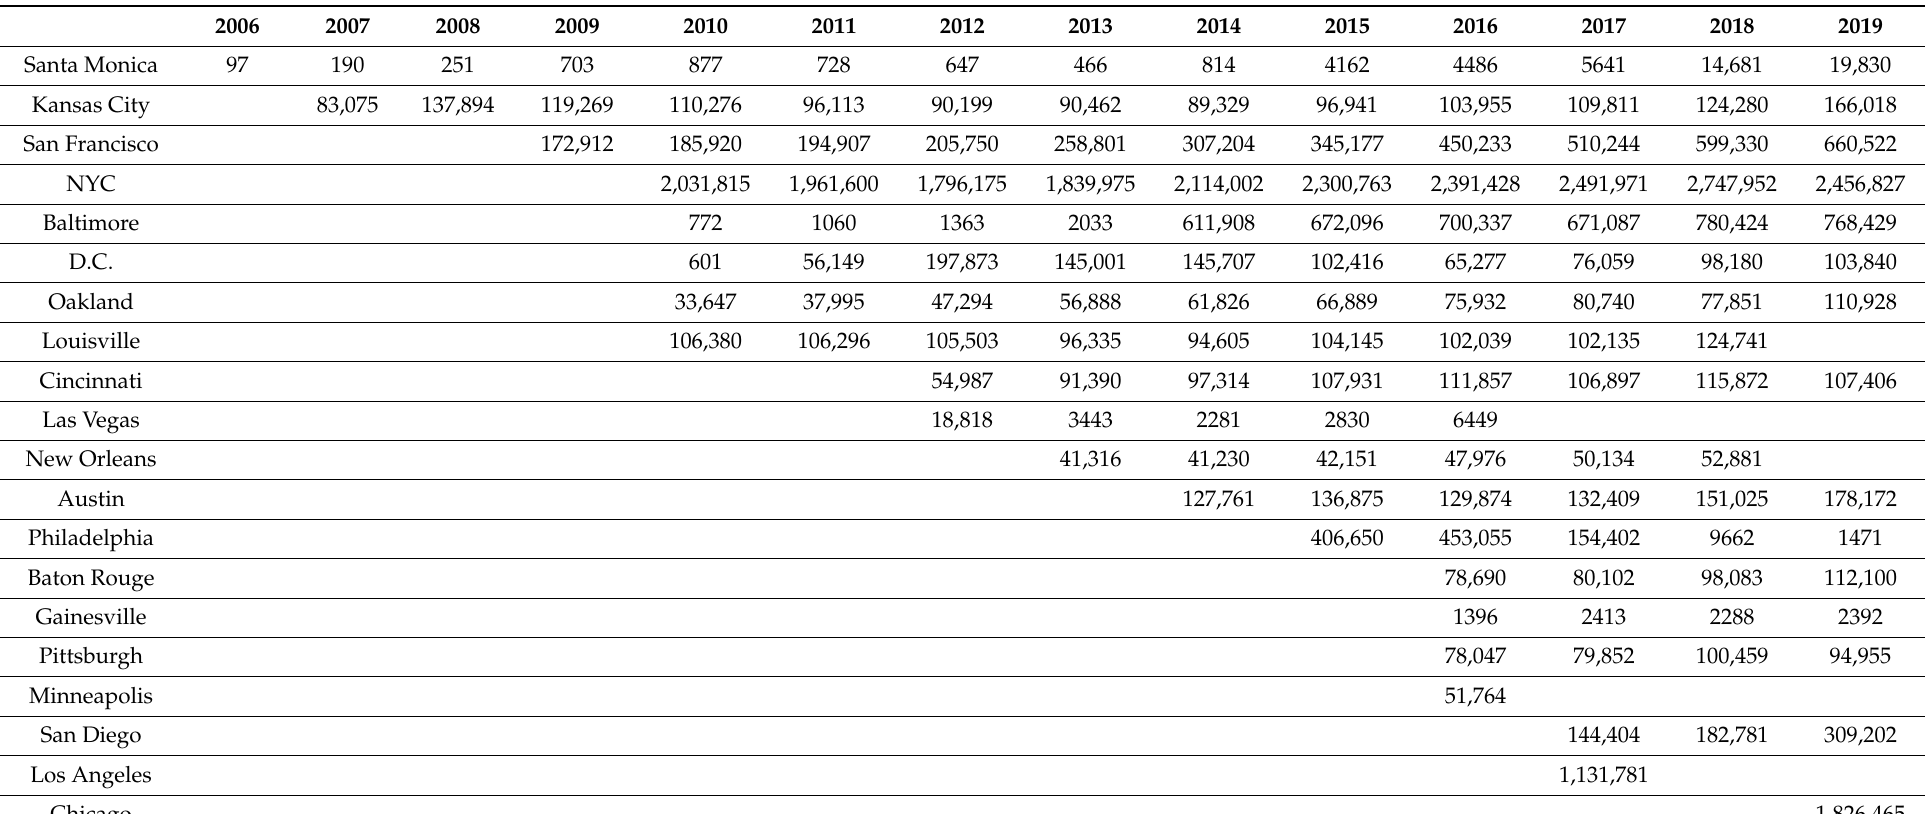
Table 1. Number of SRs per year and in each